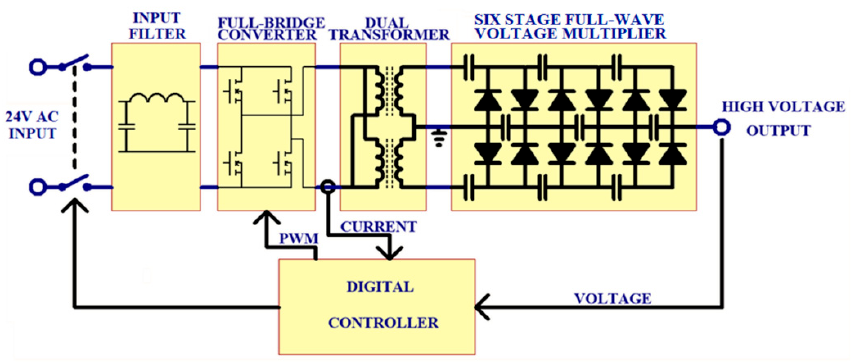
Figure 11. Block diagram of high voltage power supply.